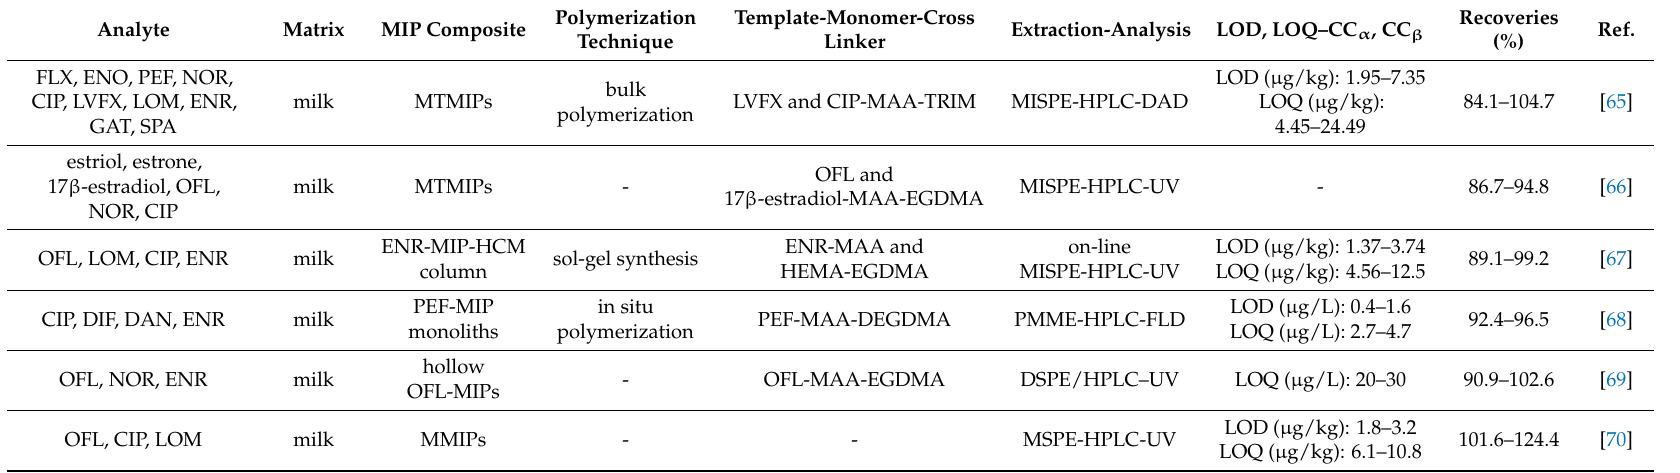
Table 3. MIPs applications for the determination of quinolones in milk